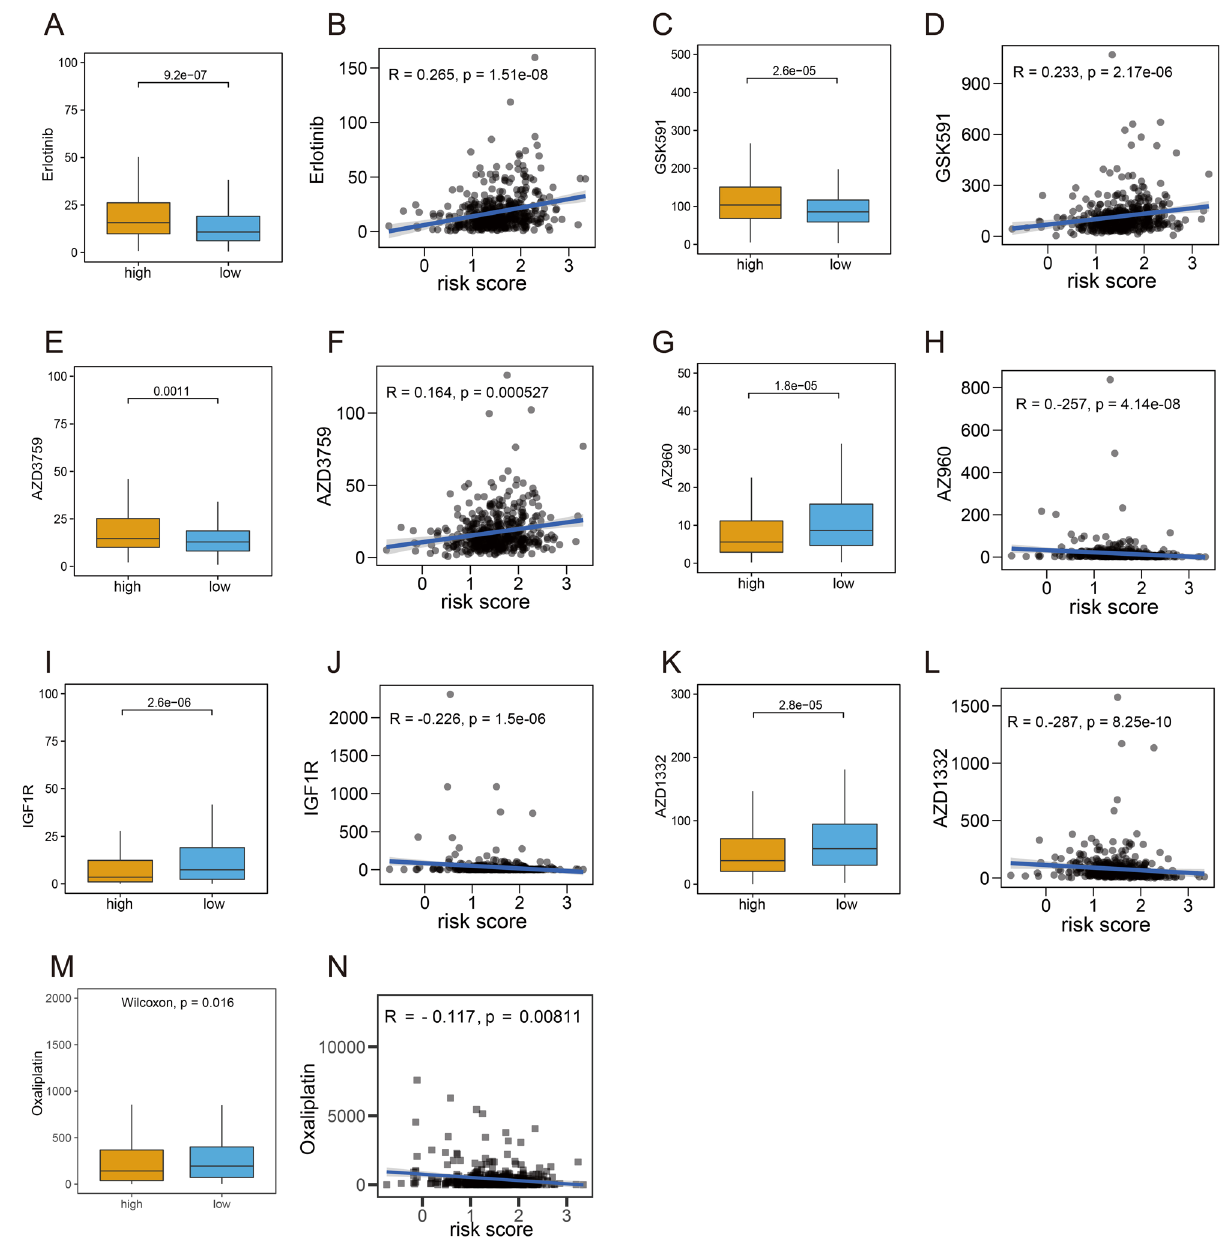
Figure 7. Identification of potential drugs. ( A,C,E,G,I,K,M ) Drug sensitivity analysis between high- and low- risk groups. ( B,D,F,H,J,L,N ) The relationship between butyrate metabolism risk scores and